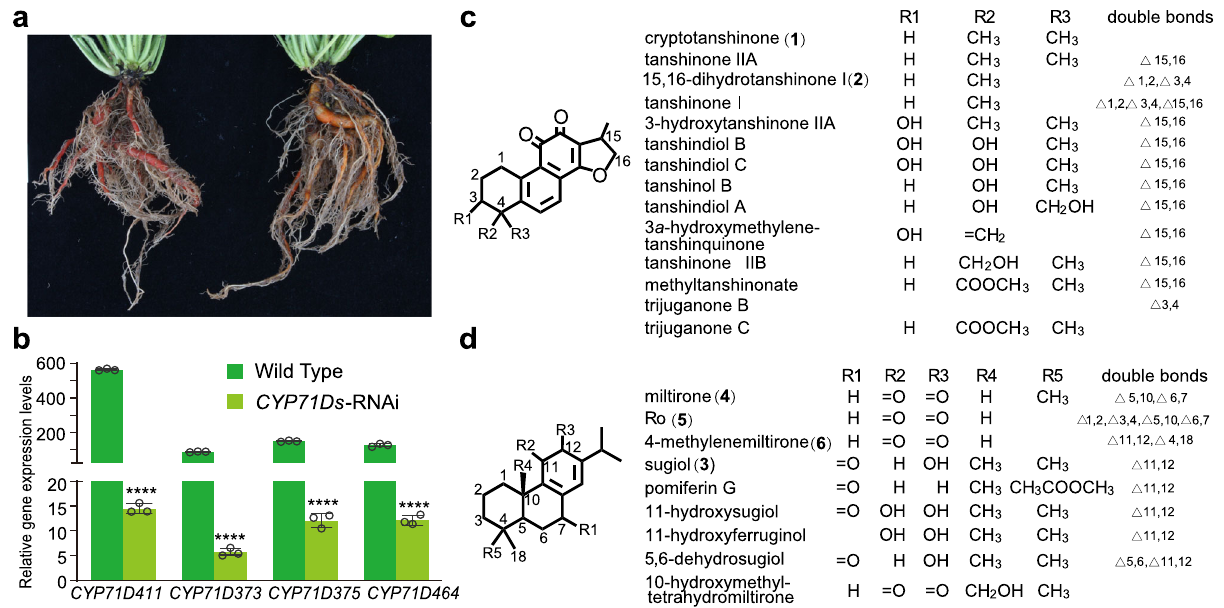
Fig. 4 Phenotype, expression and metabolite pro fi le changes of CYP71Ds- RNAi plants. a Coloration of roots from WT (left) and CYP71Ds -RNAi knockdown (right) plants. b Relative mRNA levels of the four CYP71D genes in CYP71Ds -RNAi and wild-type plants from transcriptome data. Error bars represent standard deviation SD ( n = 3 biologically independent samples; **** P < 0.0001 by 2-sided Student ’ s t test). c Down-regulated tanshinone related diterpenoids in roots of CYP71Ds -RNAi relative to WT plants. d Up-regulated tanshinone related diterpenoids in roots of CYP71Ds -RNAi relative to WT plants. Source data underlying Fig. 4b are provided as a Source Data fi